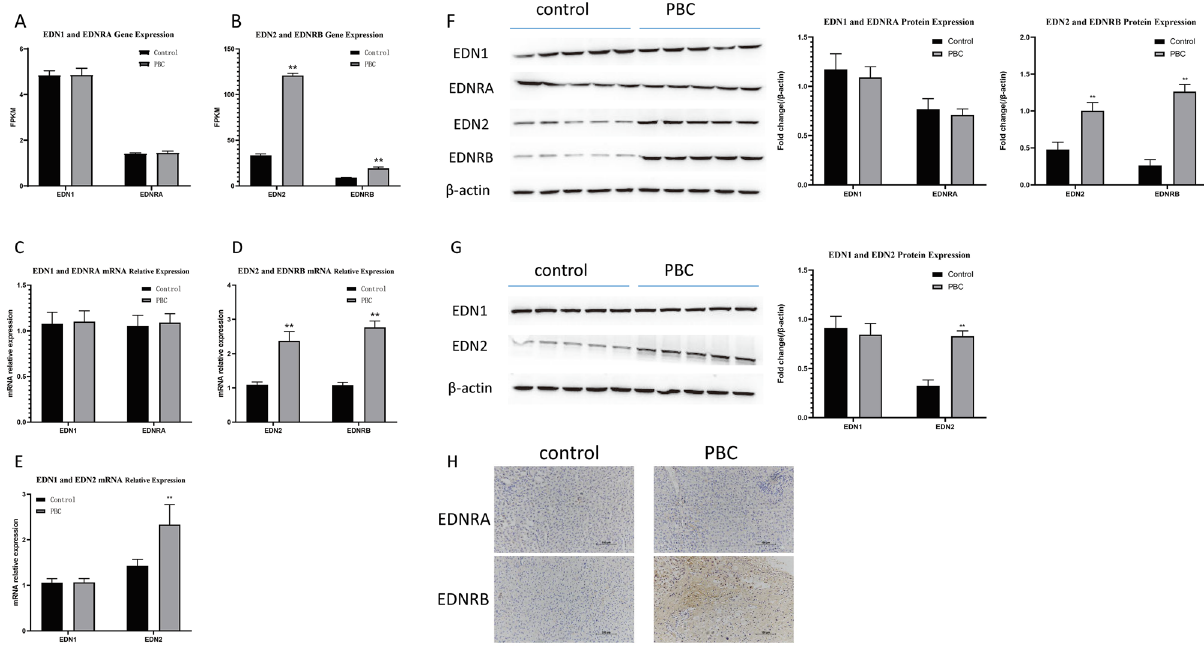
Figure 2. EDN2 and EDNRB expression levels were notably up-regulated in samples of liver tissues and sera of PBC patients relative to healthy control group. ( A and B ) RNA-seq outcomes of EDN1, EDNRA, EDN2, and EDNRB in liver tissues of patients with PBC (n = 5) and healthy volunteers (n = 5). ( C and D ) RT-qPCR technique was used to measure levels of EDN1, EDNRA, EDN2, and EDNRB mRNAs in liver tissues of patients with PBC (n = 5) and healthy volunteers (n = 5). ( E ) Determination of EDN1 and EDN2 mRNAs in sera of PBC patients (n = 10) and healthy volunteers (n = 10) was accomplished with RT-qPCR technique. ( F ) Measurement of EDN1, EDNRA, EDN2, and EDNRB proteins in liver tissues of patients with PBC (n = 5) and healthy volunteers (n = 5) was carried out with western blotting technique. ( G ) We examined the protein levels of EDN1 and EDN2 in serum samples of 5 random PBC patients and 5 random healthy volunteers with western blotting technique. ( H ) Illustrative IHC images of EDNRA and EDNRB in liver tissues of healthy people and patients with